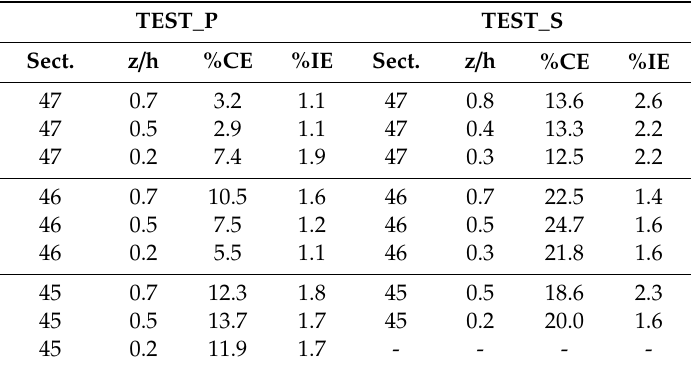
Table 2. Coherent and intense coherent events detected for TEST_P and TEST_S by means of the threshold values for the signal u ’ w